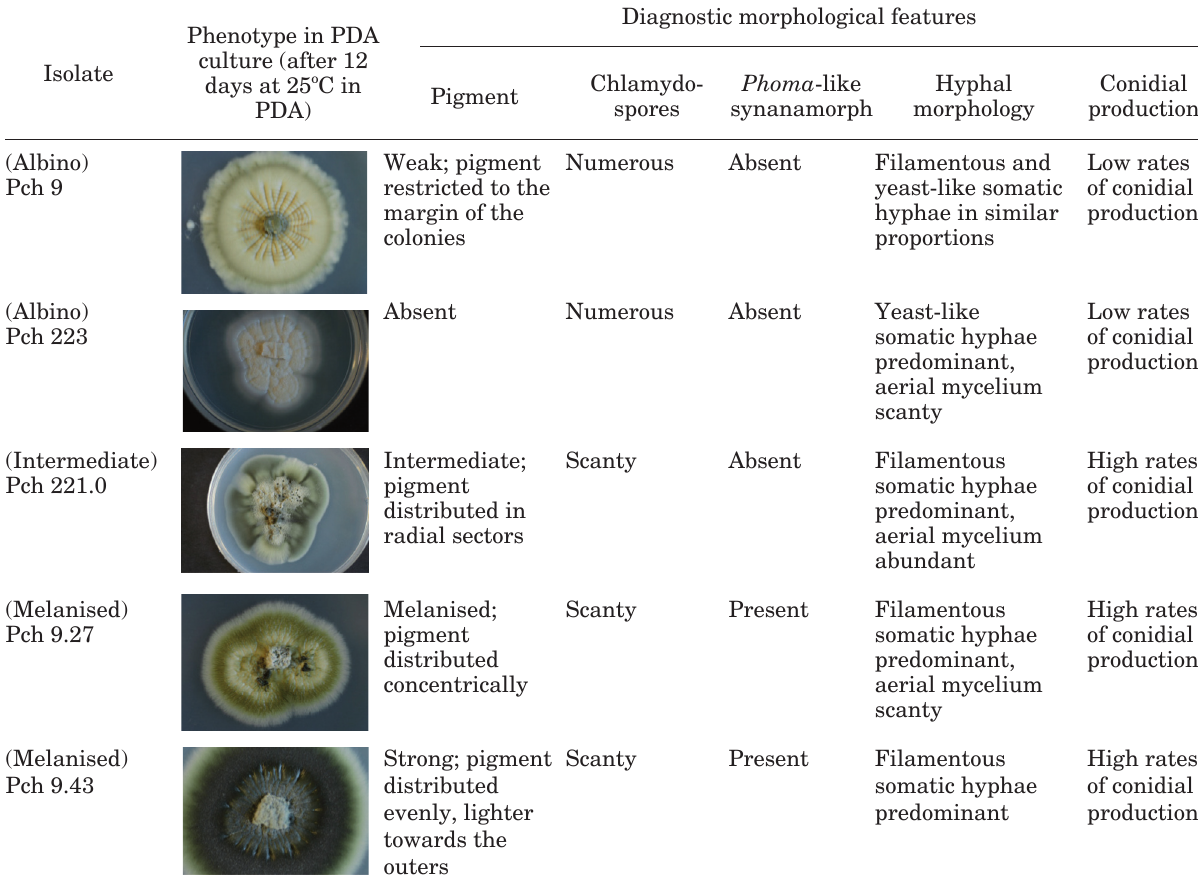
Table 2. Strain name and diagnostic macro- and morphological features of representative strains of the five morphotypes recognised among a collection of 57 Spanish isolates of Phaeomoniella chlamydospora .